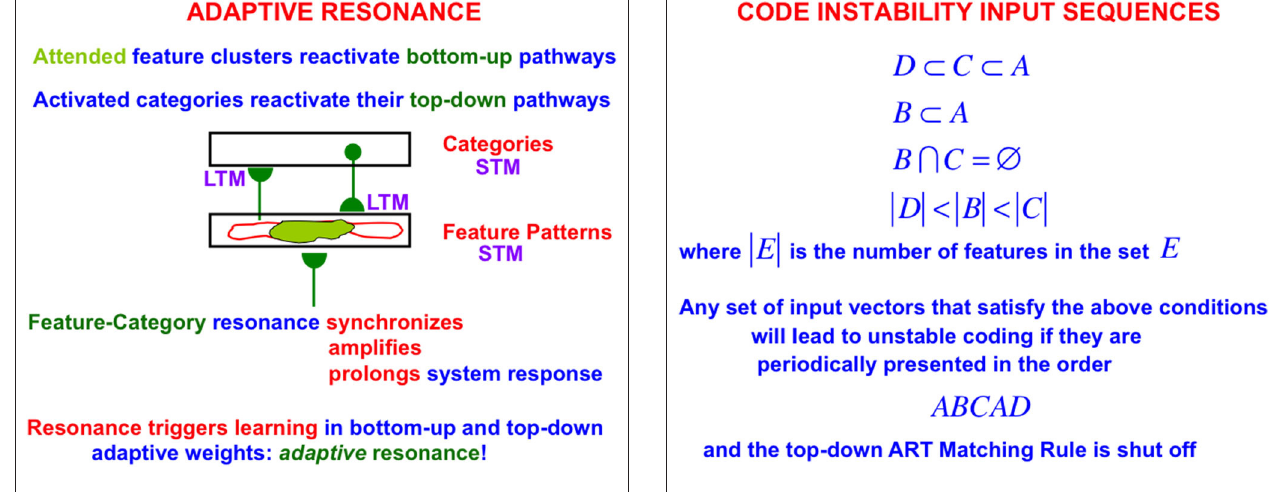
FIGURE 4 | When a good enough match occurs between a bottom-up input pattern and top-down expectation, a feature-category resonance is triggered the synchronizes, amplifies, and prolongs the STM activities of the cells that participate in the resonance, while also selecting an attentional focus and triggering learning in the LTM traces in the active bottom-up adaptive filter and top-down expectation pathways to encode the resonating attended data [adapted with permission from Grossberg (2017b)].